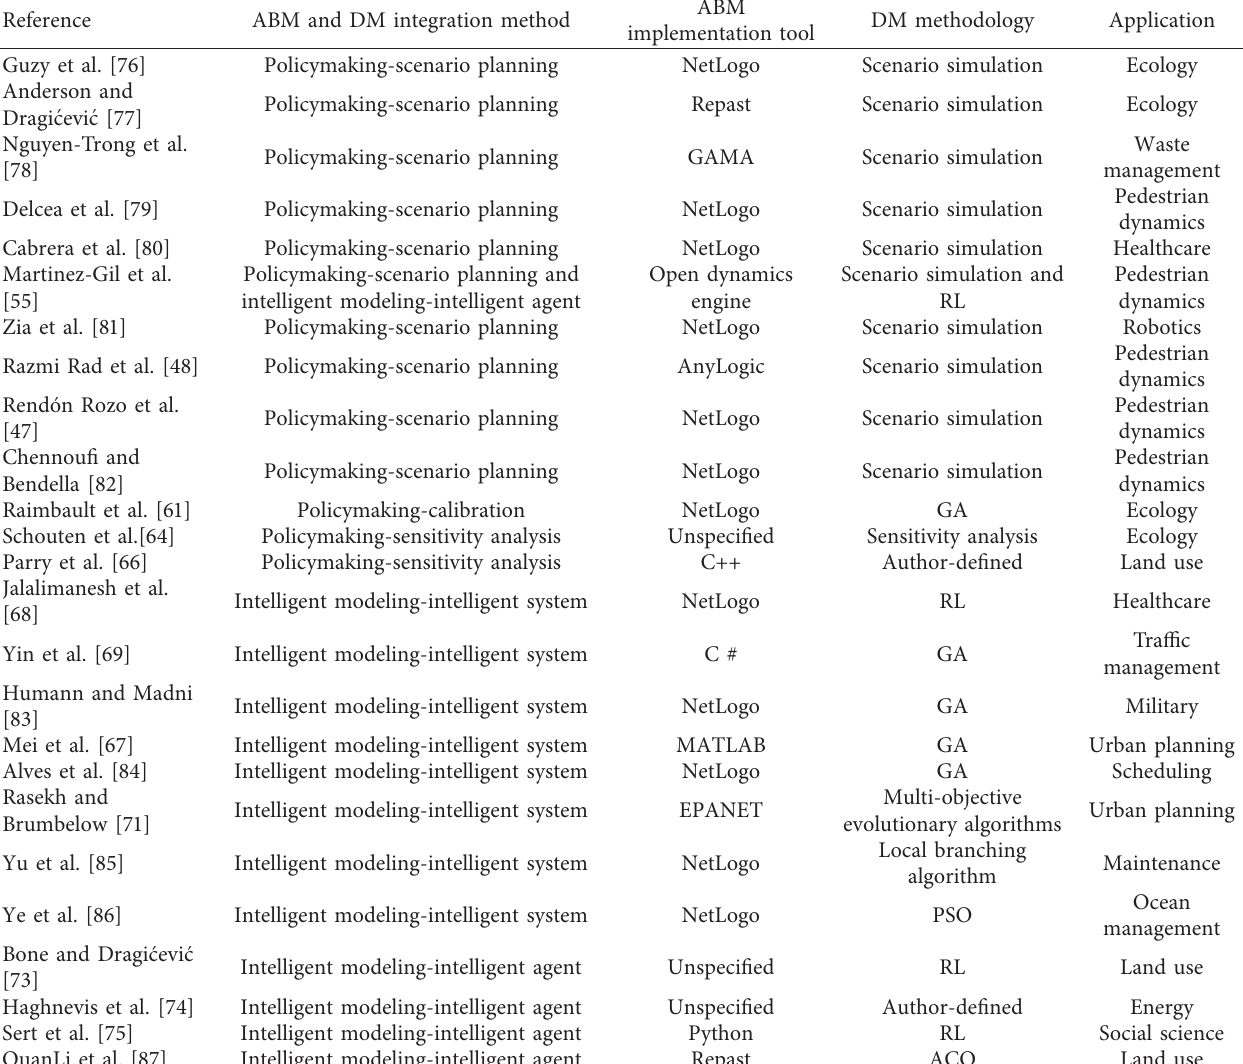
Table 1: AB-DM literature in a nutshell.